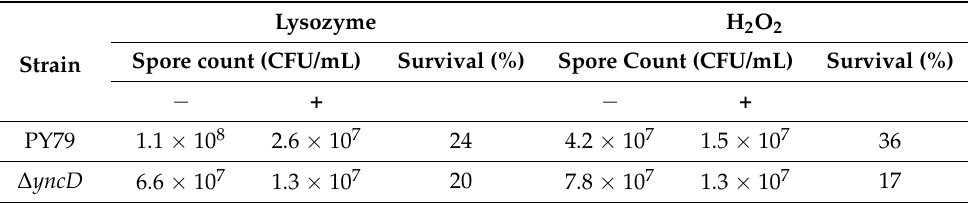
Table 1. Resistance of wild-type and ∆ yncD spores under various conditions. For resistance assays, spores were treated with lysozyme (1 mg/mL) in PBS buffer for 30 min at 37 ◦ C and 15% H 2 O 2 in PBS for 10 min. Resistance of spores was followed as the number of colonies forming units before and after treatment.